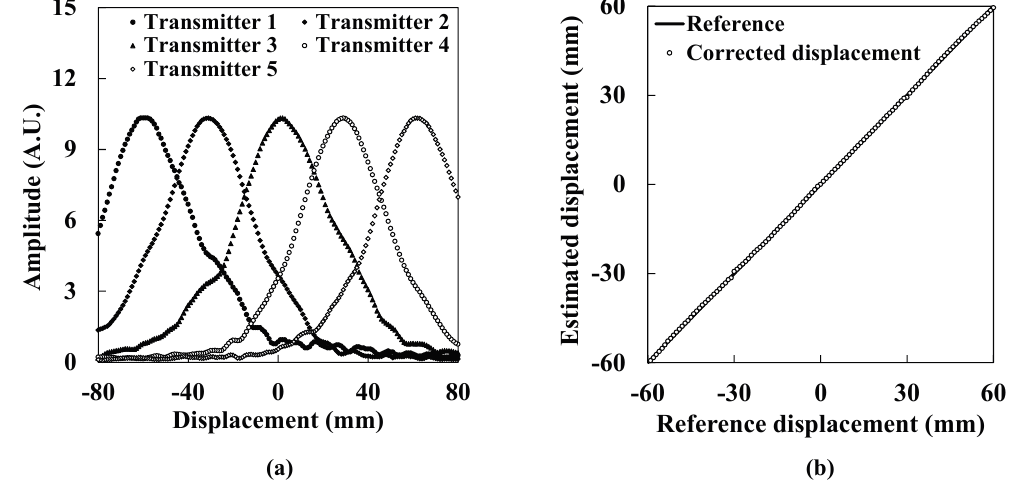
Figure 11. Measuring lateral displacement over a wide range. ( a ) The ultrasound intensity distribution obtained from five transmitters; ( b ) The corrected lateral